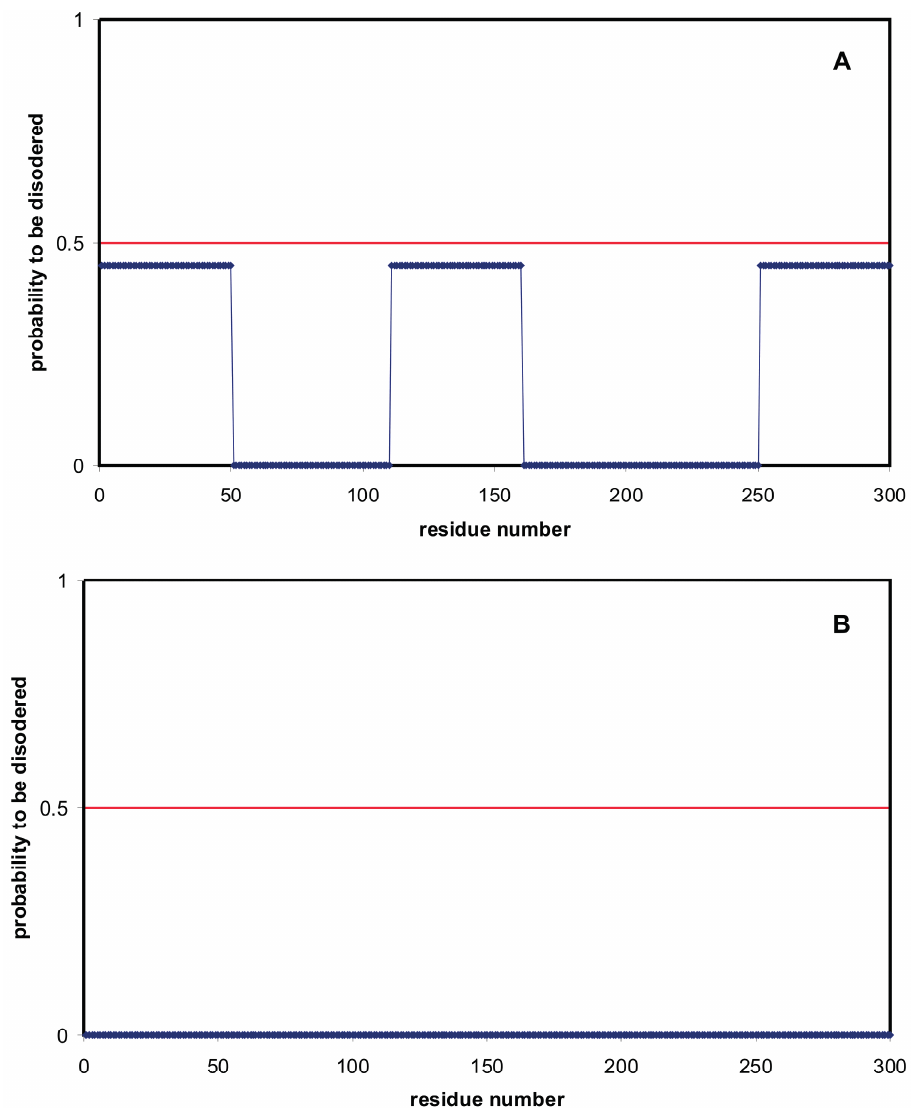
Figure 9. Prediction of disordered residues for artificial proteins ( A ) and ( B ) (blue curves). Red line corresponds the border between disordered and ordered residues, below